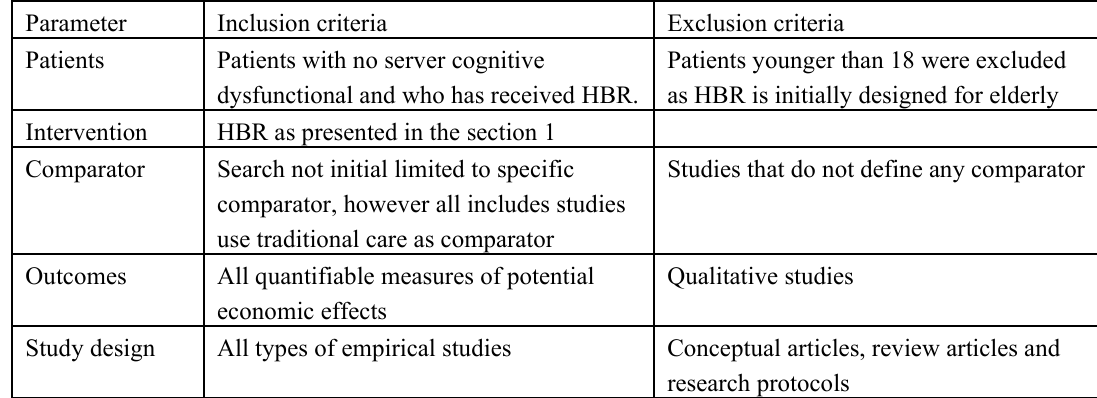
Table 1: PICOS table for inclusion and exclusion